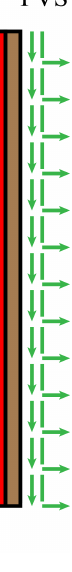
Figure 6. Images of ISF flow in the perivascular space (PVS). Kong and Yu et al. [28] found in their experimental observations the ISF flow within the perivascular and adventitial clearances (PAC). The ISF flow within the PAC may be correlated with two movements. One is the pulsation of the artery and the other is the